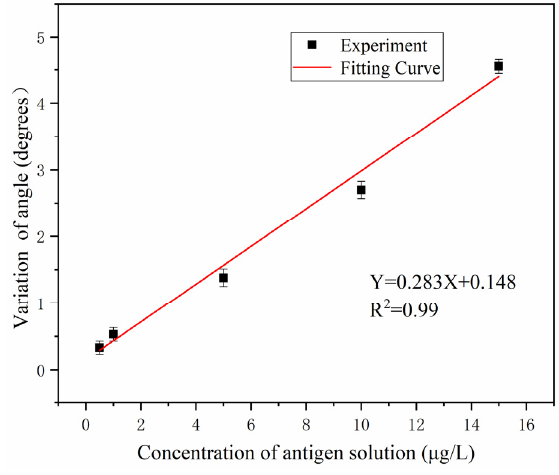
Figure 9. The relationship between different concentrations of the β -LG antigen and the angle spectrum redshift.